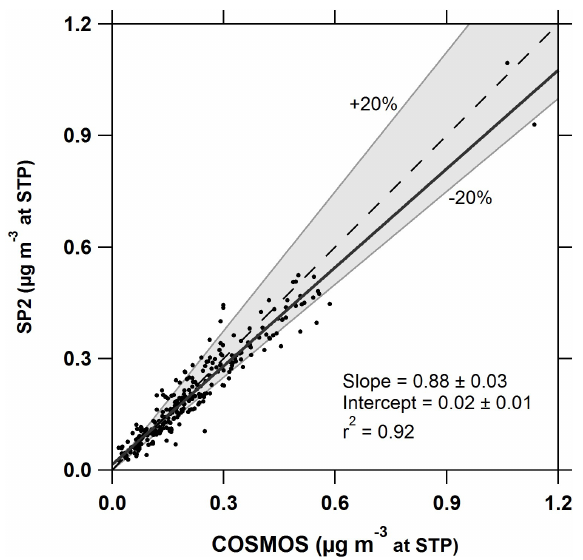
Figure 2. Correlation plot of SP2–rBC and COSMOS–EBC mass concentrations (at standard temperature and pressure). The shaded region corresponds to within ± 20% from the 1:1 line (the dashed line). The bold line depicts the linear